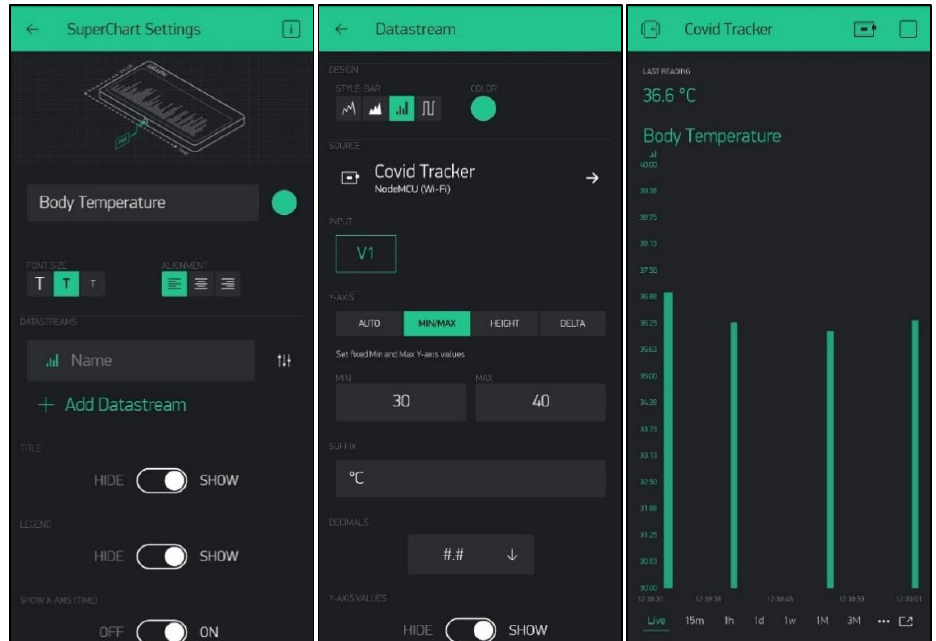
Figure 9. Configuring and displaying body temperature data on the Blynk IoT client dashboard.